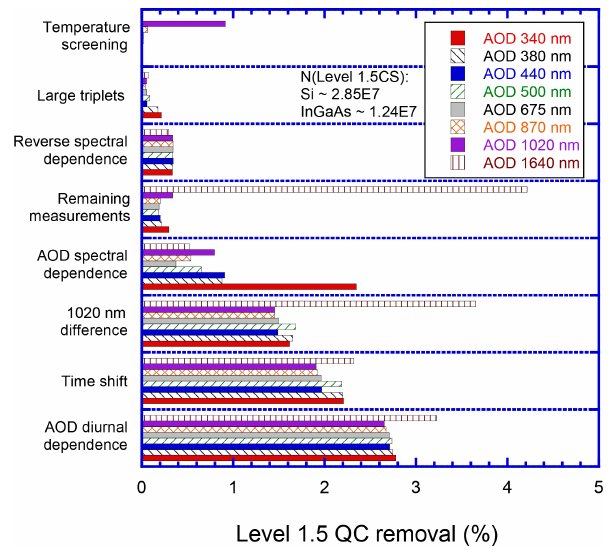
Figure 16. The Level 1.0 AOD measurement removal by the Level 1.5 cloud-screening algorithm from 1993 to 2018. The plot shows the impact of the major cloud-screening steps in the Level 1.5 cloud-screening algorithm and removal of these data applies to all wavelengths. The triplet criterion removes more than 23% of the Level 1.0 data. Nearly 5% of the Level 1.0 data are removed due to cirrus cloud contamination. The “remaining” category indicates the check performed after each cloud-screening step to determine if enough measurements are available and do not meet the high AOD retention criteria. The “unqualified” category indicates data that are not triplets or lack sufficient channels to participate in the cloud- screening algorithm.